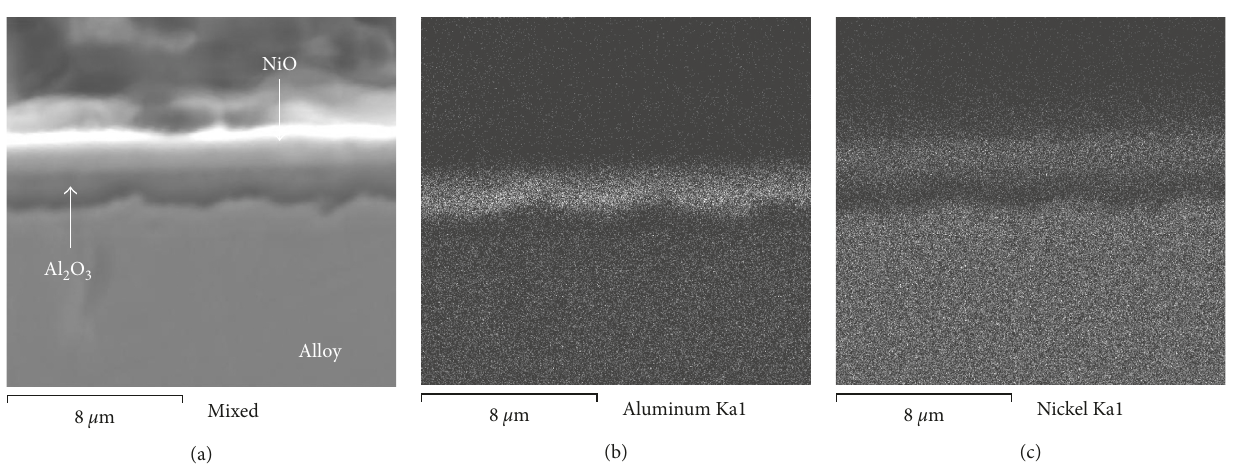
Figure 8: SEM micrograph (a) and mapping elements (b, c) of the scale formed onto Ni